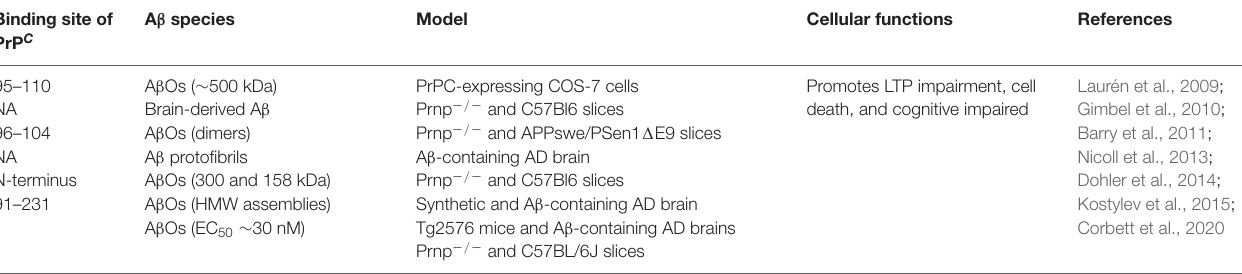
TABLE 2 | A β –PrP C interaction